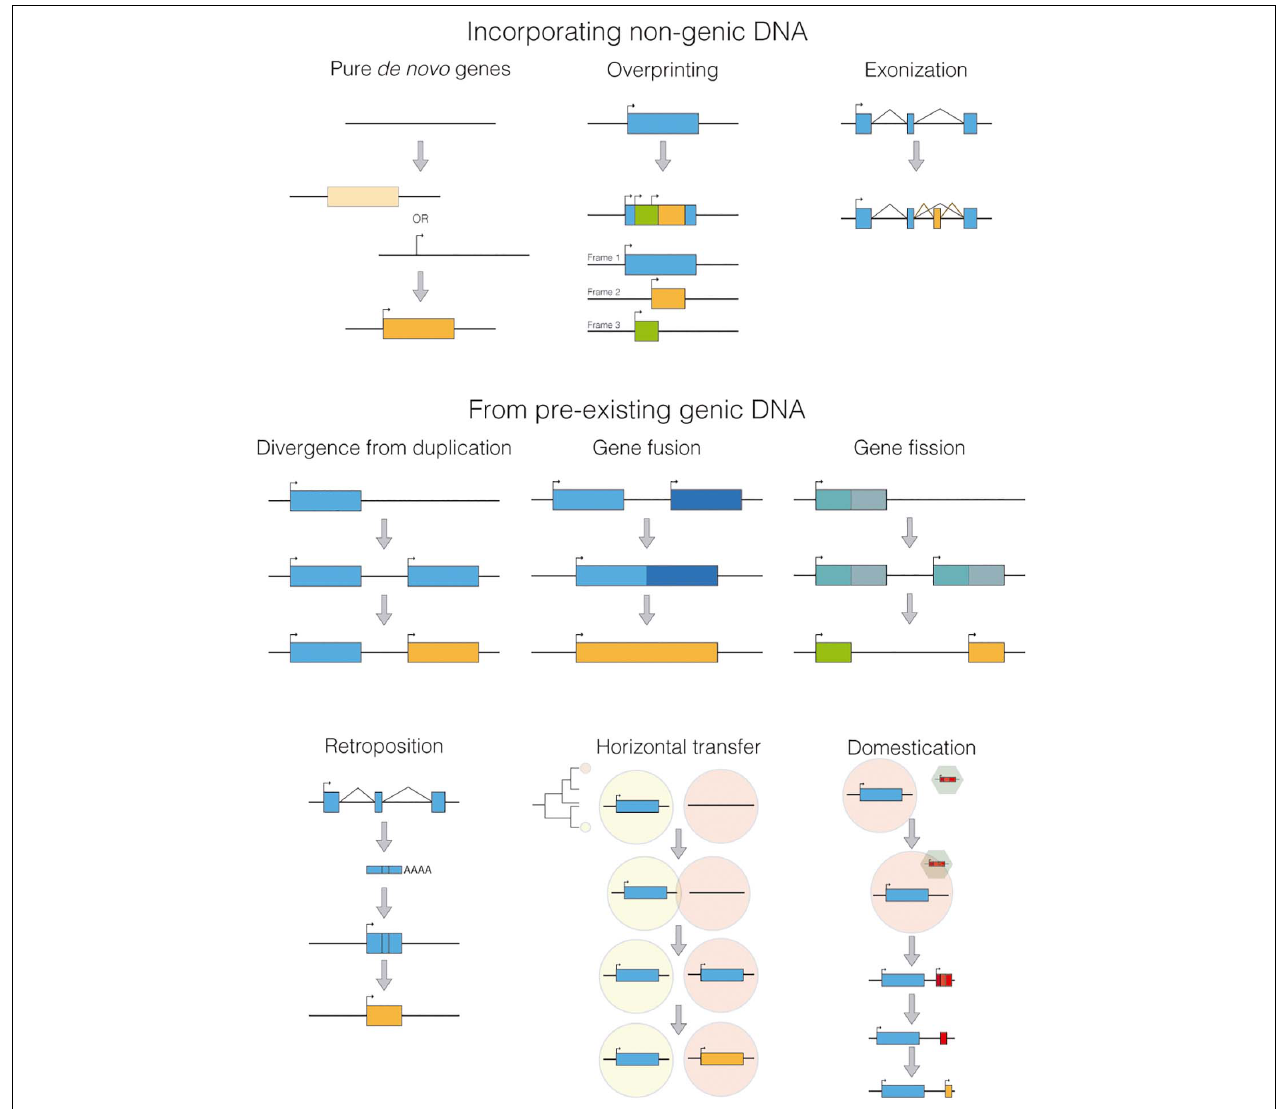
FIGURE 2 | Different mechanisms for generating taxonomically restricted genes.